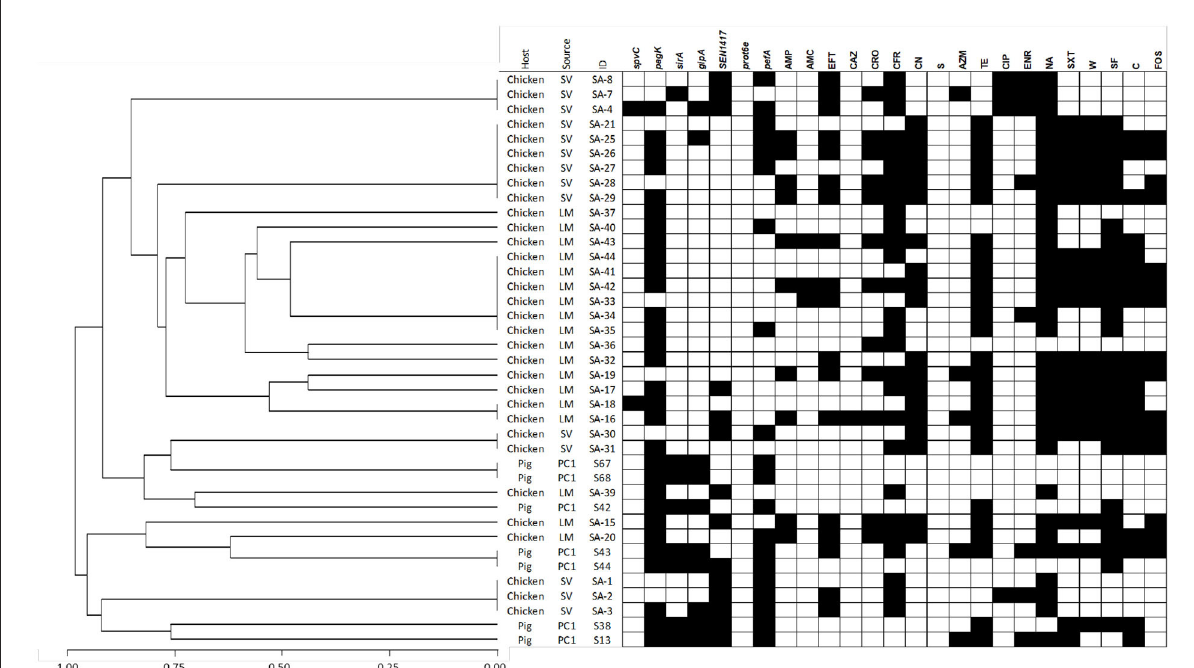
FIGURE1 Dendrogram showing genetic similarities (%) among S. Infantis isolates analyzed using multiplex PCR. Detection of virulence-associated genes and antimicrobial resistance phenotypes are depicted as black squares when present. The dendrogram was constructed using a hierarchical clustering, using the average linkage method and Jaccard’s